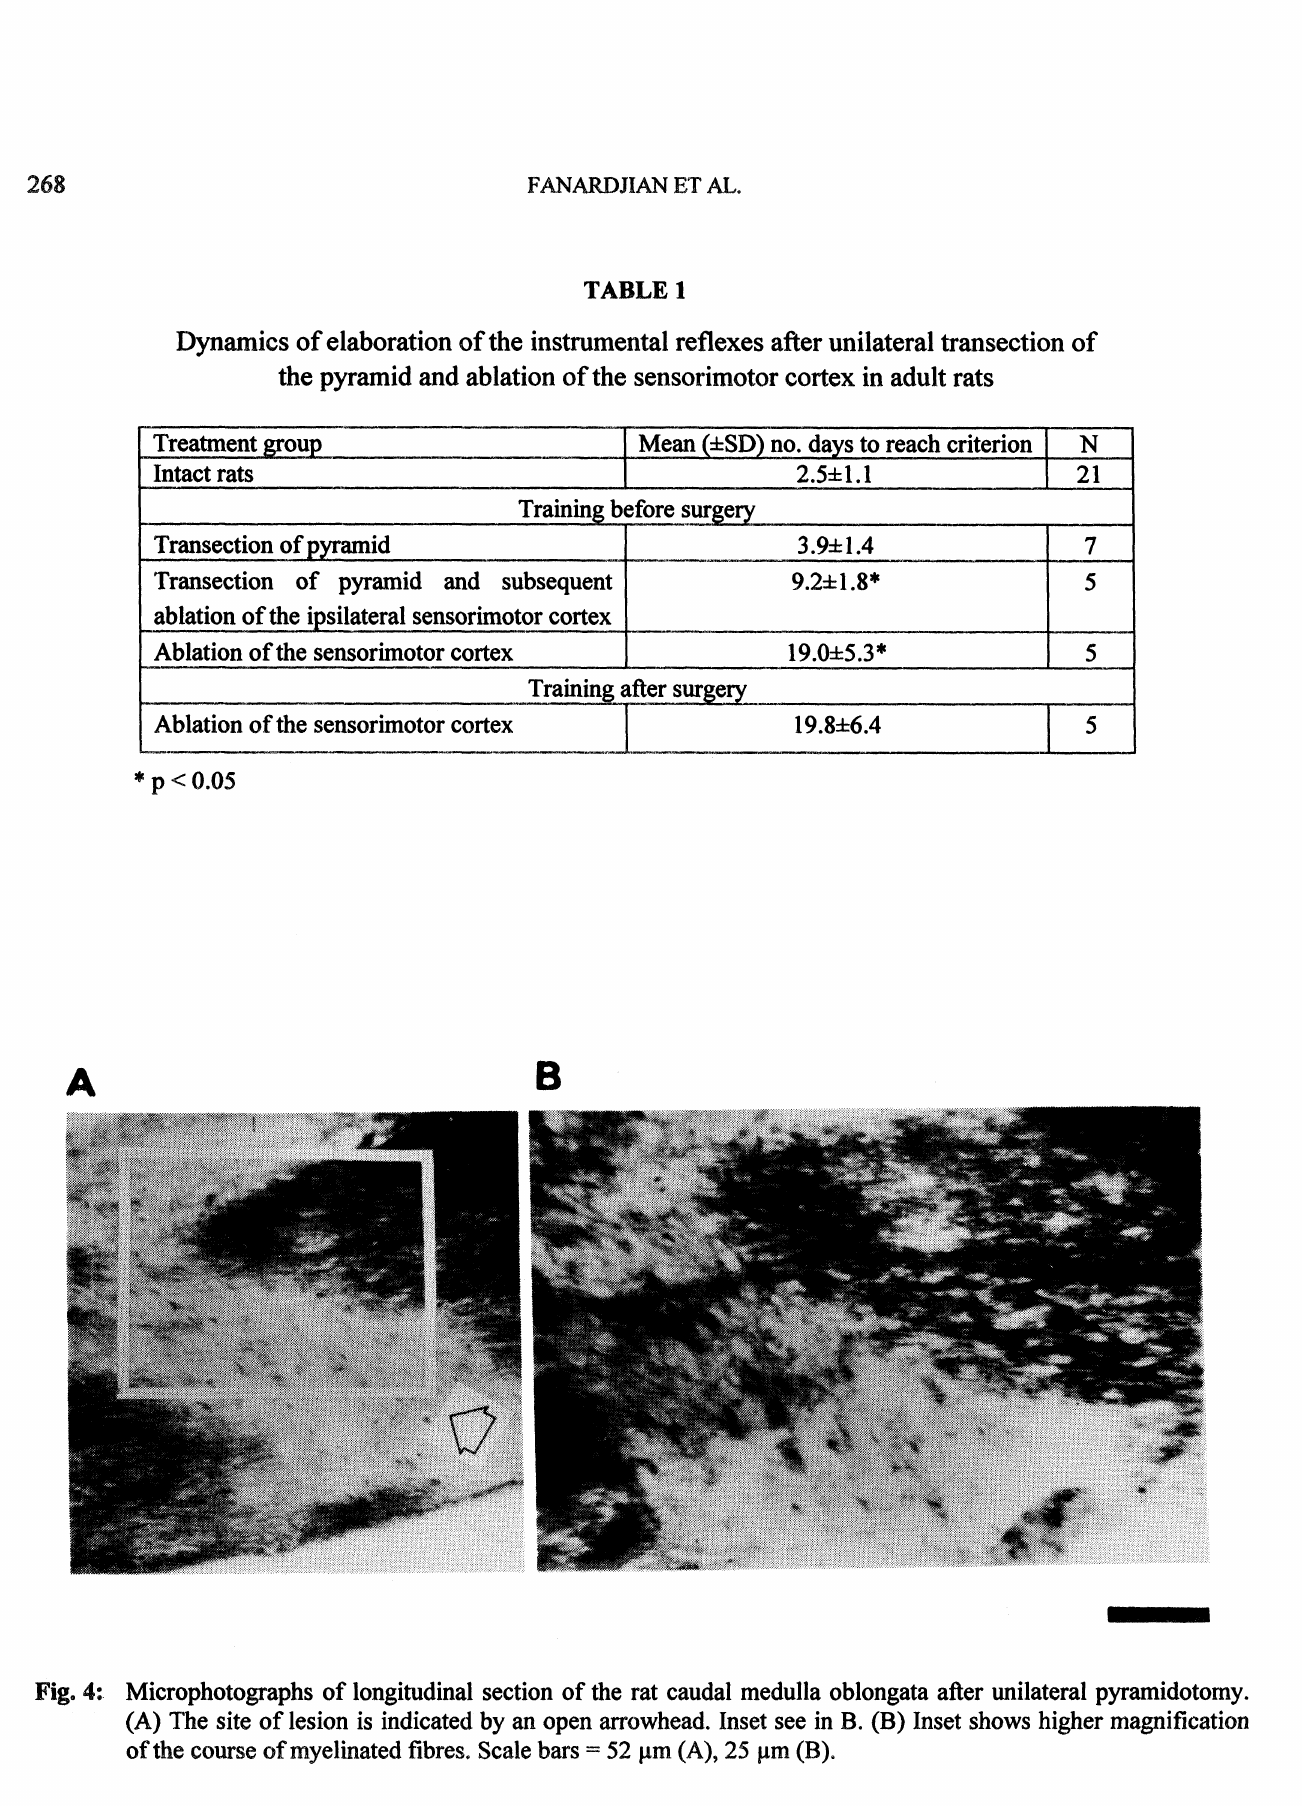
Fig. 4:. Microphotographs of longitudinal section of the rat caudal medulla oblongata after unilateral pyramidotomy. (A) The site of lesion is indicated by an open arrowhead. Inset see in B. (B) Inset shows higher magnification ofthe course of rnyelinated fibres. Scale